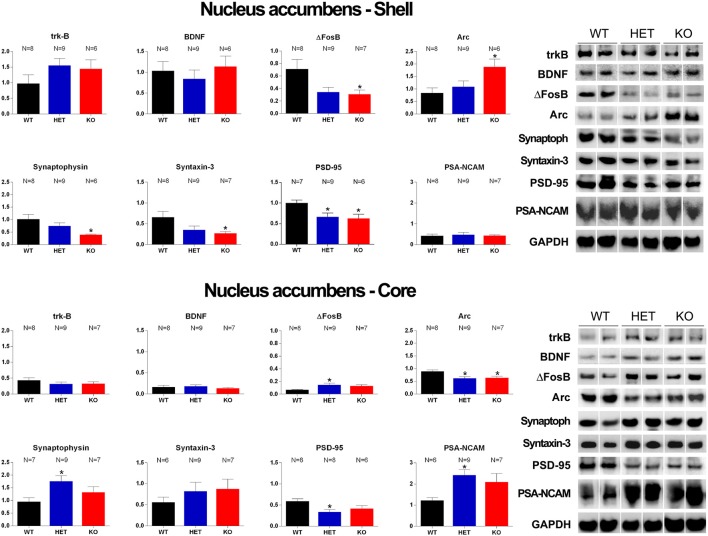
Western Blot analysis of trkB, BDNF, Δ-FosB, Arc, synaptophysin, syntaxin-3, PSD-95 and PSA-NCAM in the Acb shell and Acb core of WT, HET and DAT KO rats after the microdialysis experiment. Histograms on the left are the densitometric analyses of the marker/GAPDH band gray optical density (O.D.) ratios. Blot lines on the right are representative samples of two animals from each experimental group. Values are means ± SEM of the values obtained by the reported number of rats per group. *P < 0.05 with respect to WT rats (one-way ANOVA followed by Tukey’s pairwise comparisons).